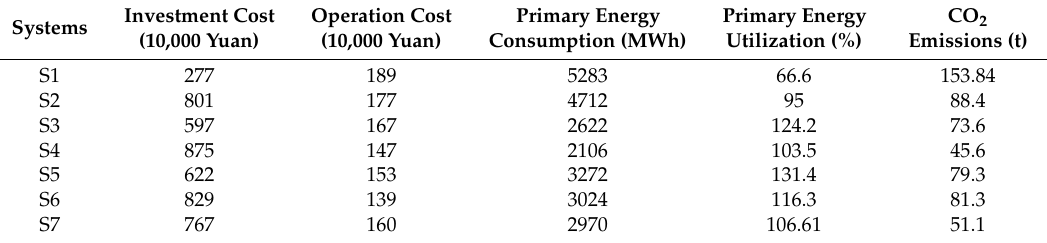
Table 2. Basic data of the seven systems.